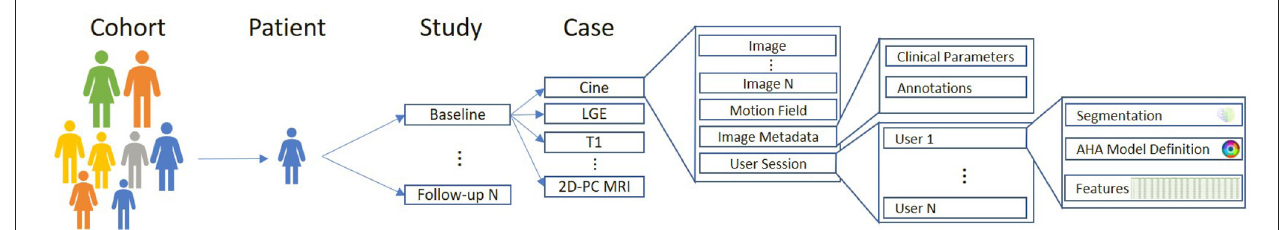
FIGURE 2 | Schematic representation of the data